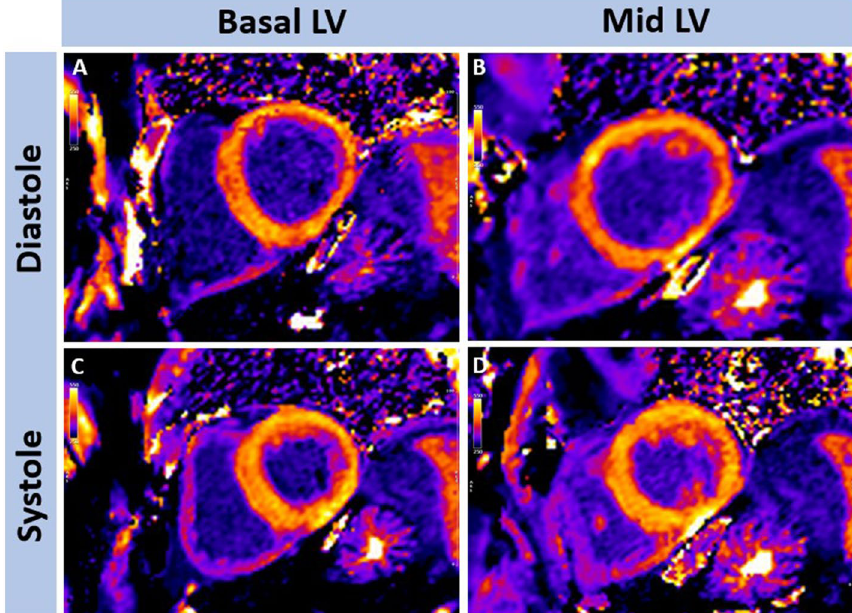
Figure 1. Examples of differences in left ventricular (LV) myocardial thickness following T1 mapping within the same patient in diastole and systole at the basal ( A + C ) and mid ( B + D ) left ventricular level in diastole ( A + B ) and systole ( C + D ),